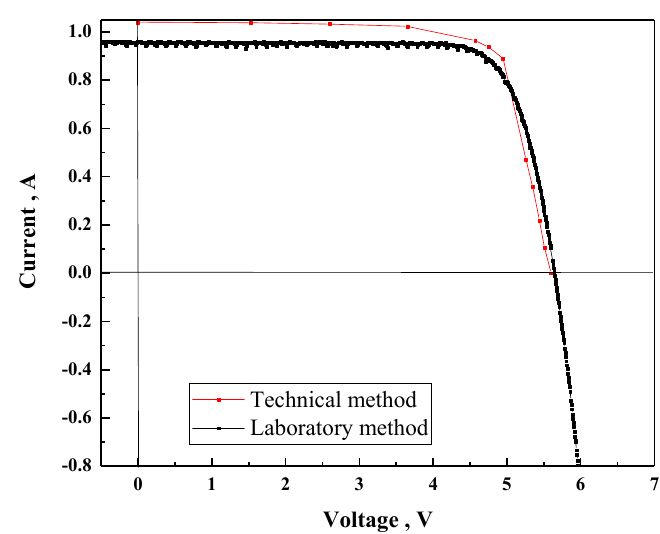
Figure 7. Current-voltage characteristic of PV module acquired by two di ff erent methods: laboratory and technical.